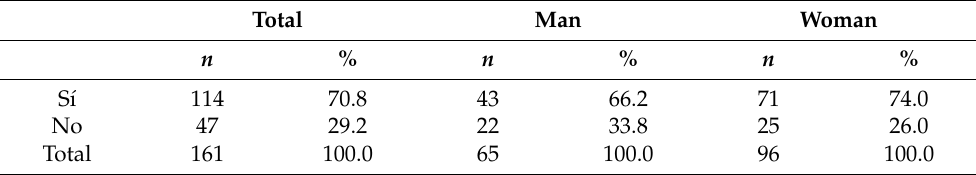
Table 3. Knowing the difference between unprocessed or minimally processed, processed and ultra-processed